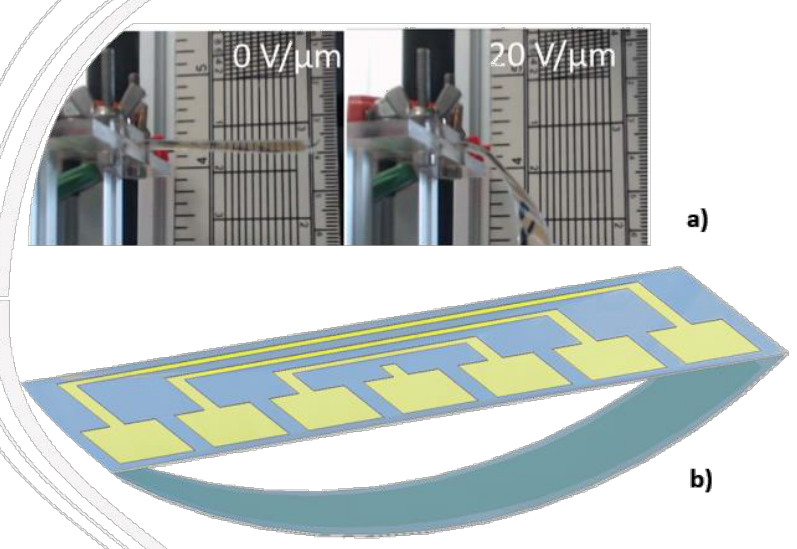
Figure 10. Active displacement control based on electrostrictive materials: ( a ) Actuator in flexion mode; ( b ) CAD design of an ideal benchmark.